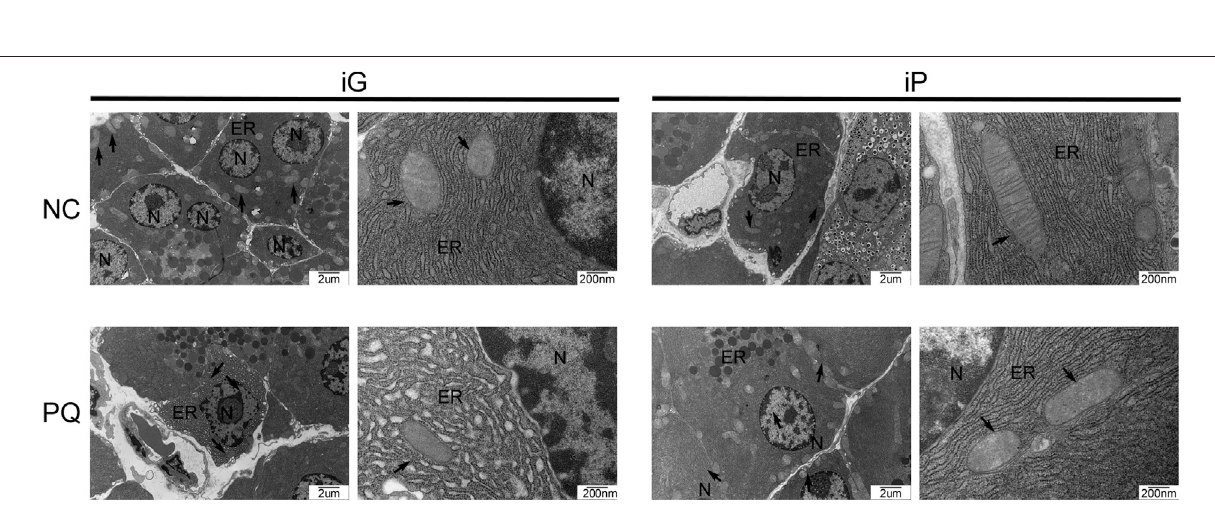
Frontiers in Pharmacology |